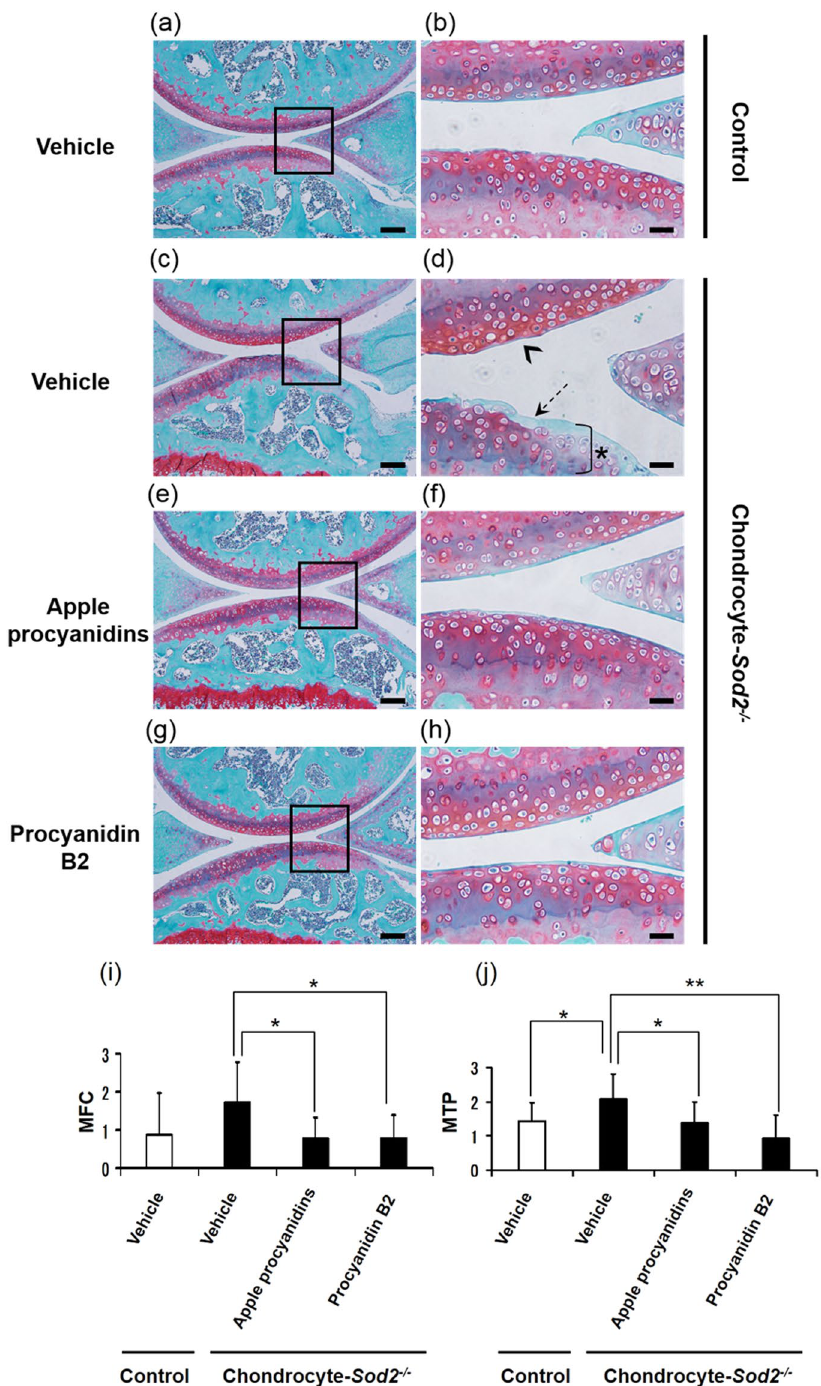
Figure 5. Apple procyanidins and procyanidin B2 suppress cartilage damages in knee joints of chondrocyte- Sod2 − / − mice under mechanical overloading. The left knee joints of mice were treated with DMM surgery at 8 weeks of age and administered 500 mg/kg apple procyanidins or 100 mg/kg procyanidin B2 for 8 weeks. ( a – h ) Cartilage degeneration in safranin O/fast green-stained sections of the medial region of knee joints from control and chondrocyte- Sod2 − / − mice. Scale bars represent 100 µ m and 1 mm for the left and right panels, respectively. The arrowhead, dotted arrow, and asterisk represent cartilage fibrillation, cartilage degeneration/erosion, and loss of safranin O intensity, respectively. (i and j) Quantification of cartilage degeneration in the medial region; the left graph indicates the quantification of cartilage degeneration in the medial femoral condyle (MFC), and the right graph indicates the quantification of cartilage degeneration in the medial tibial plateau (MTP). Values are the mean ± standard deviation (n = 10–12, * P < 0.05, ** P < 0.01 versus control, Student’s t